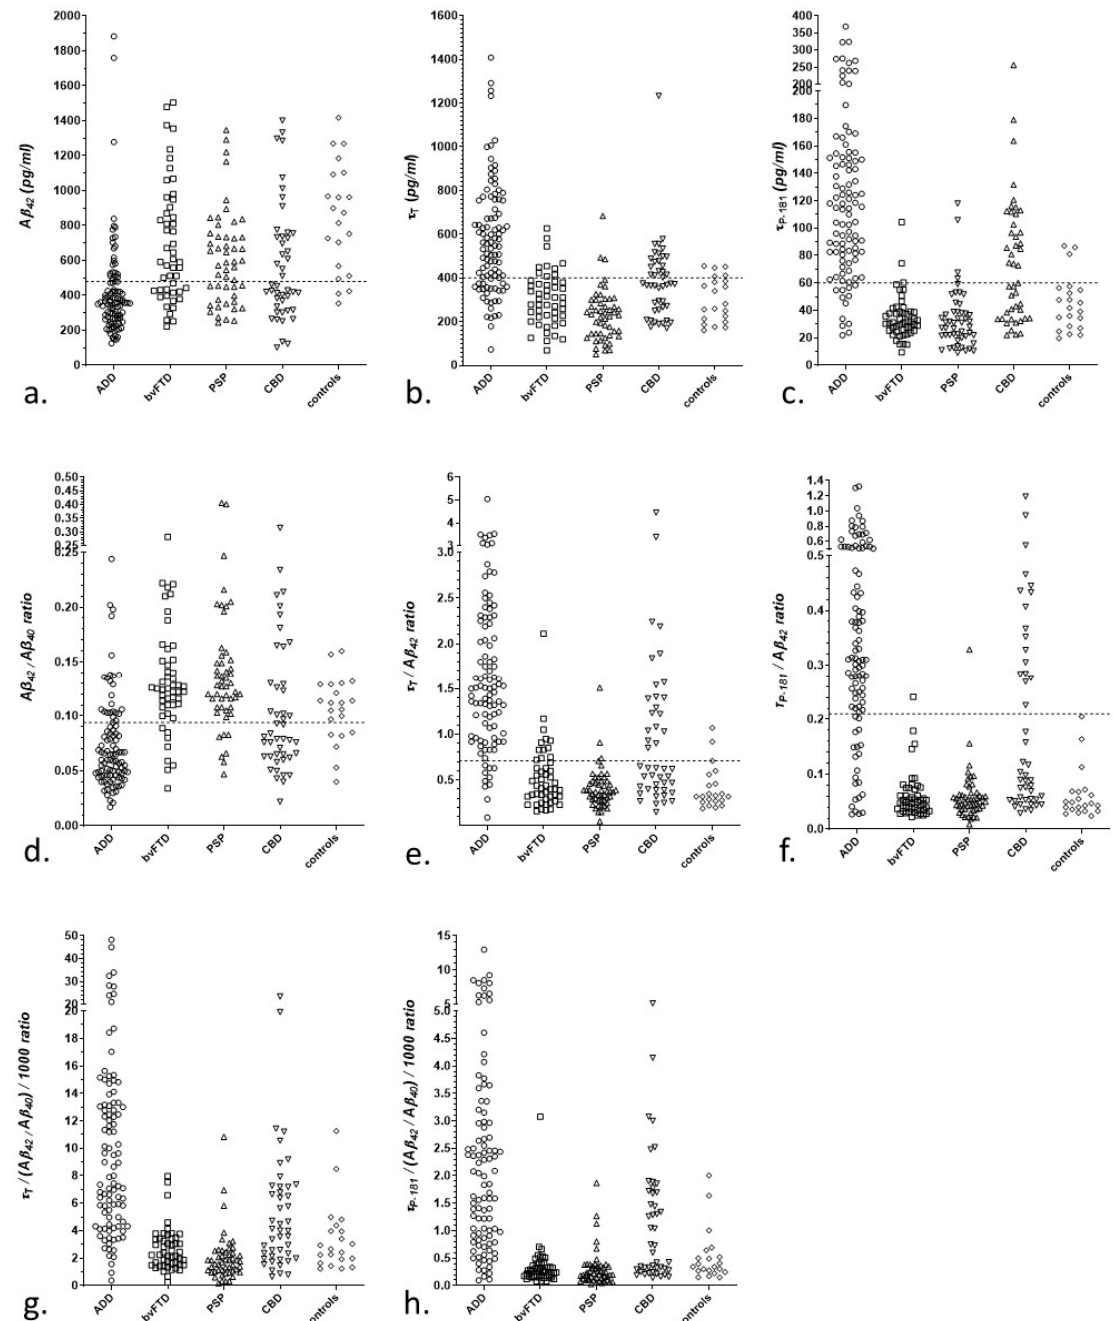
Figure 1. Scatterplots of CSF biomarkers ( a – c ), biomarker ratios ( d – f ) and composite markers ( g – i ) in study groups. Dotted lines represent normal values of our Laboratory. Data are presented for A β 42 ( a ); τ T ( b ); τ P-181 ( c ); Αβ 42 / Αβ 40 ratio ( d ); τ T /A β 42 ratio ( e ); τ P-181 /A β 42 ratio ( f ); composite t-tau marker ( τ T /( Αβ 42 / Αβ 40 ) ( g ); composite ph-tau marker ( τ P-181 /(A β 42 / Αβ 40 ) ( h ); and composite global marker ( τ Τ * τ P-181 /A β 42 ) ( ι ).